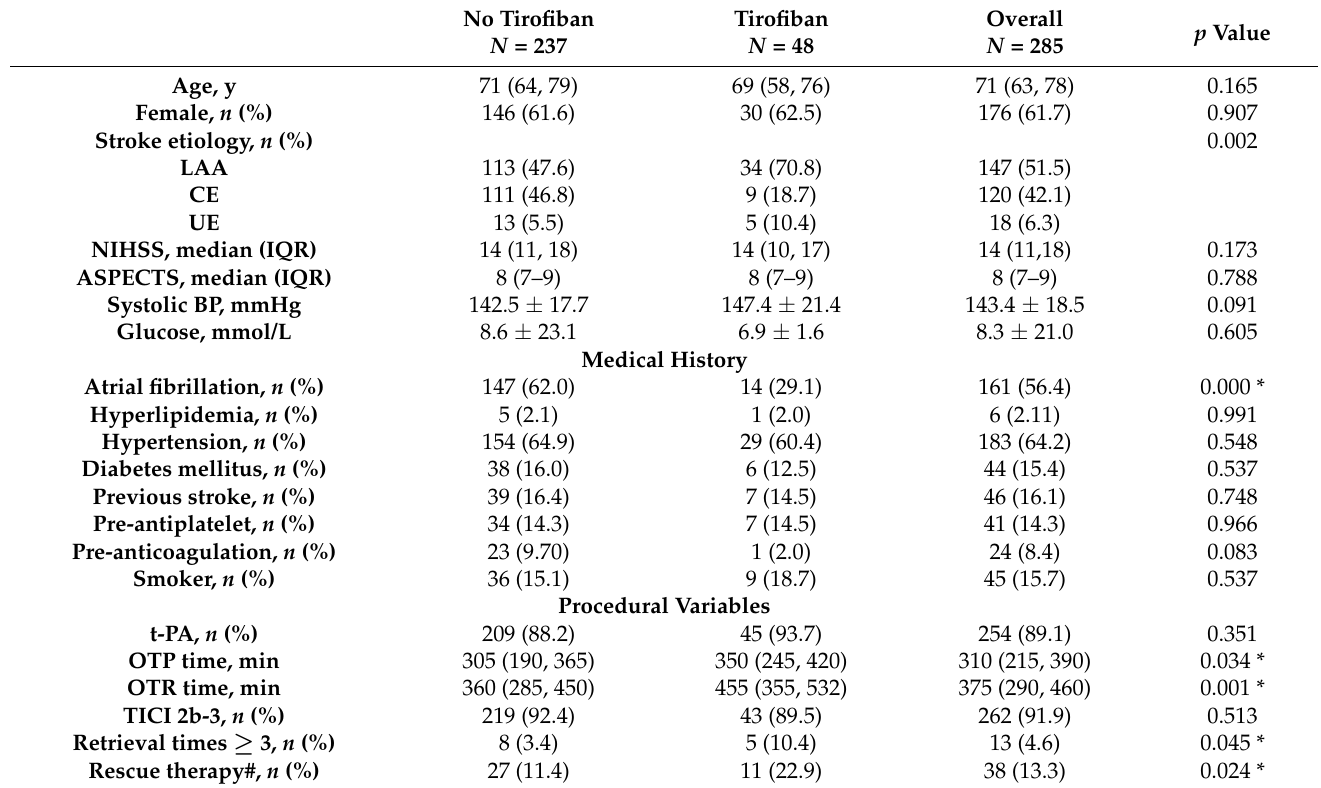
Table 1. Patient characteristics and clinical